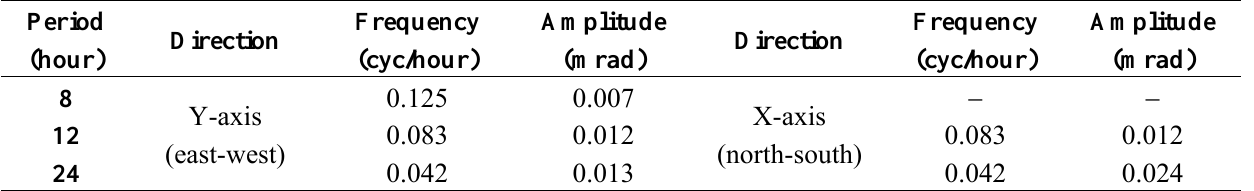
Table 3. LSSA results of inclination data: periodicities of resonant movements of the tall building .